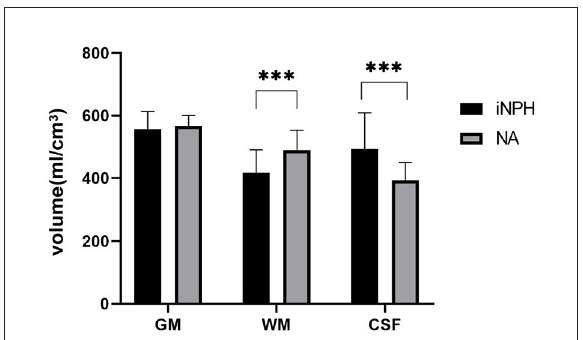
FIGURE2 The difference in gray matter volume between the idiopathic normal-pressure hydrocephalus (iNPH) group and normal aging (NA) group. iNPH, idiopathic normal-pressure hydrocephalus; NA, normal aging; GM, gray matter; WM, White matter; CSF, Cerebrospinal fluid. *** P ≤